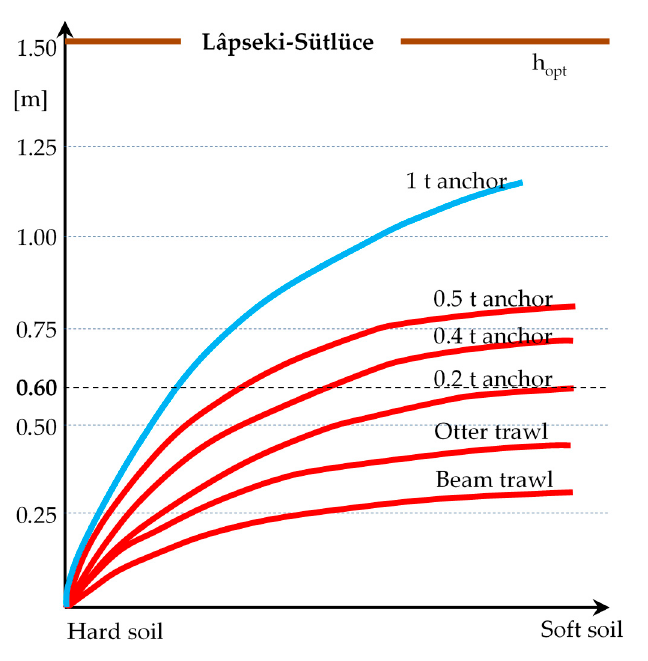
Figure 7. Penetration of smaller anchors and fishing gears versus soil hardness.